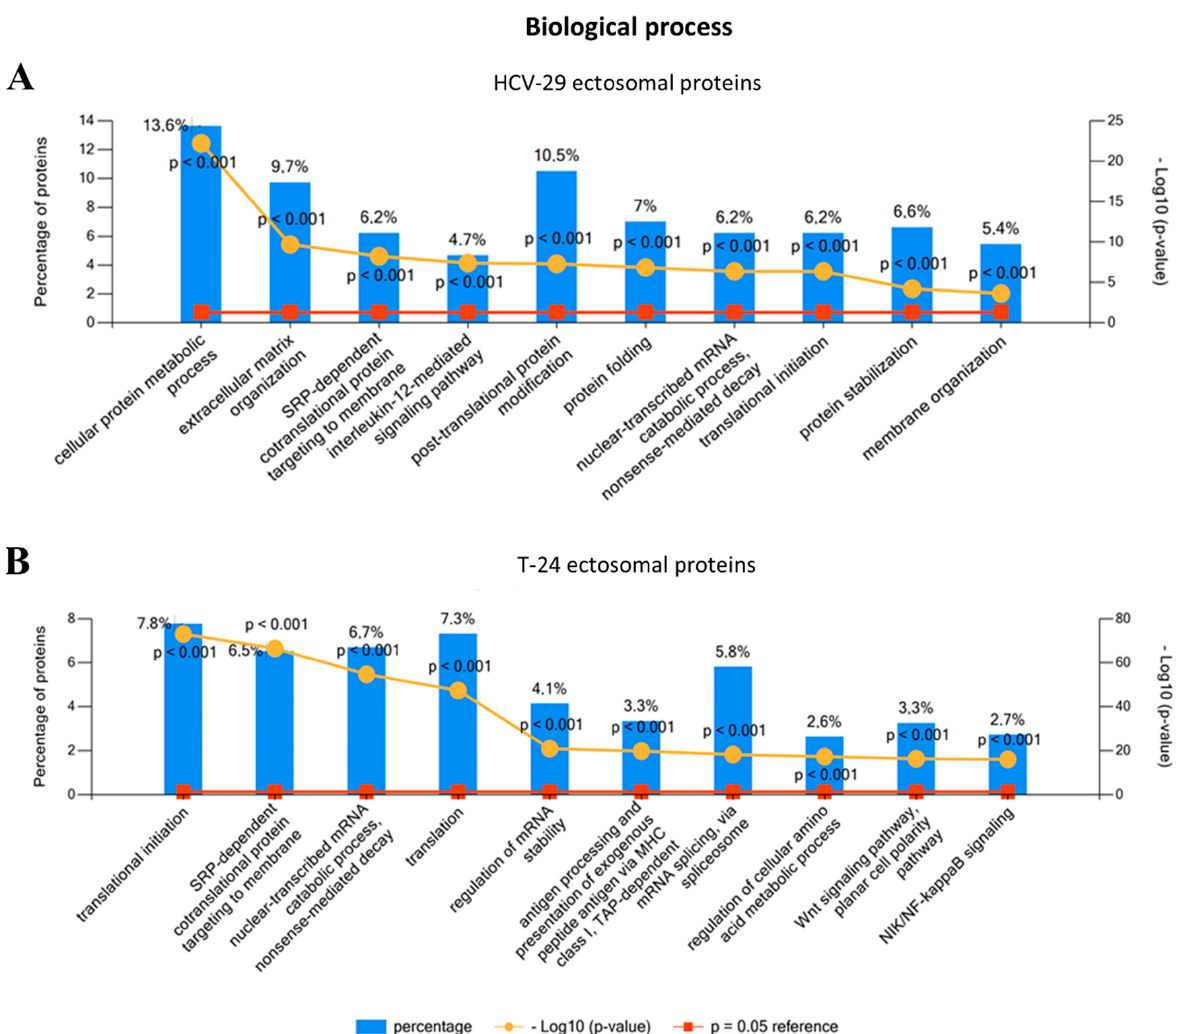
Figure 4. Gene ontology (GO) analysis of proteins identified in ectosomes derived from HCV-29 normal ureter epithelial cells ( A ) and T-24 urothelial bladder carcinoma cells ( B ) performed with the use of FunRich 2.0 software with UniProt (release 2020_12) database as a reference. For GO term “Biological process” ten categories with the highest statistical significance of protein enrichment within the specific category ( p < 0.001) were presented on graphs. Complete results of GO analysis are provided in Supplementary Data S2.